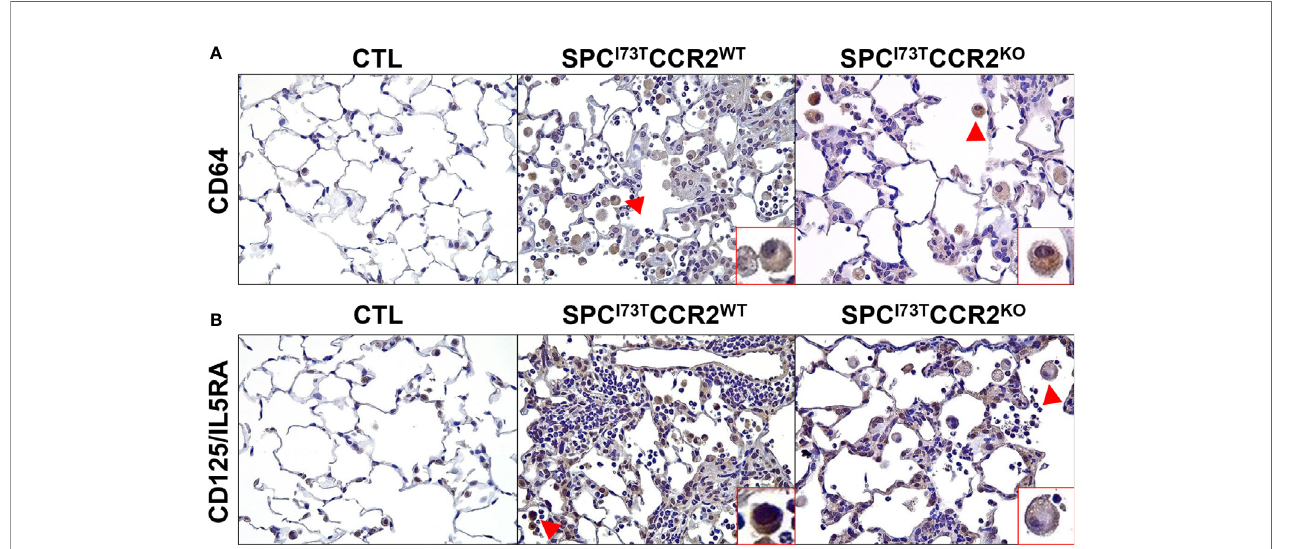
FIGURE 7 | Effects of CCR2 monocyte ablation on monocyte/macrophage maturation and recruitment following SP-C I73T induced injury. Histochemical analysis of control (CTL, tamoxifen treated SP-C WT or oil treated SP-C I73T mice), SP-C I73T CCR2 WT and SP-C I73T CCR2 KO lung sections 14 d post injury immunostained with antibody to (A) CD64 and (B) CD125/IL5RA. Binding was visualized using a Vectastain kit. Arrowheads indicate cells expressing the receptor. Insets show magni fi ed cells; box color matches that of respective arrowhead. Original magni fi cation, 400x; inset magni fi cation, 750x. Representative sections from 3 mouse/group are shown.